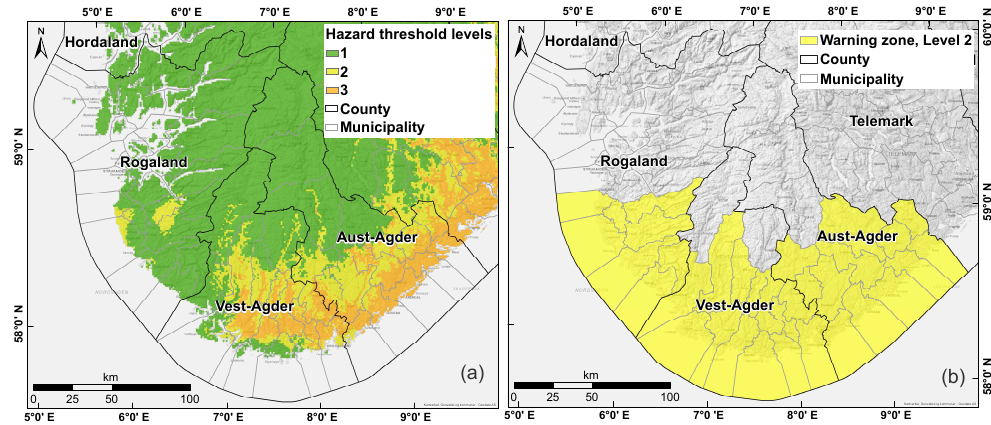
Figure 2. (a) Hydrometeorological thresholds indicating potential landslide hazard in the counties of Rogaland, Vest-Agder, Aust-Agder and Telemark in south-eastern Norway on 15 February 2014. (b) The resultant early warning zone, on warning level 2 (“yellow level”) issued on 15 February 2014 for the same area and including about 32 municipalities.